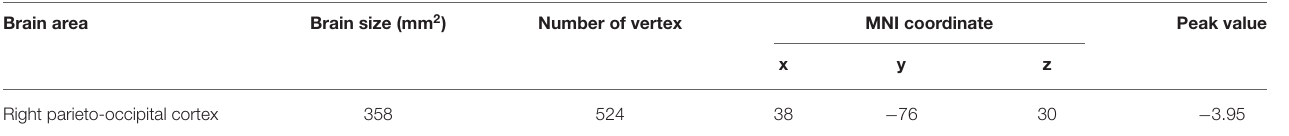
TABLE 2 | Significantly cortical thickness changes after 3-h sleep